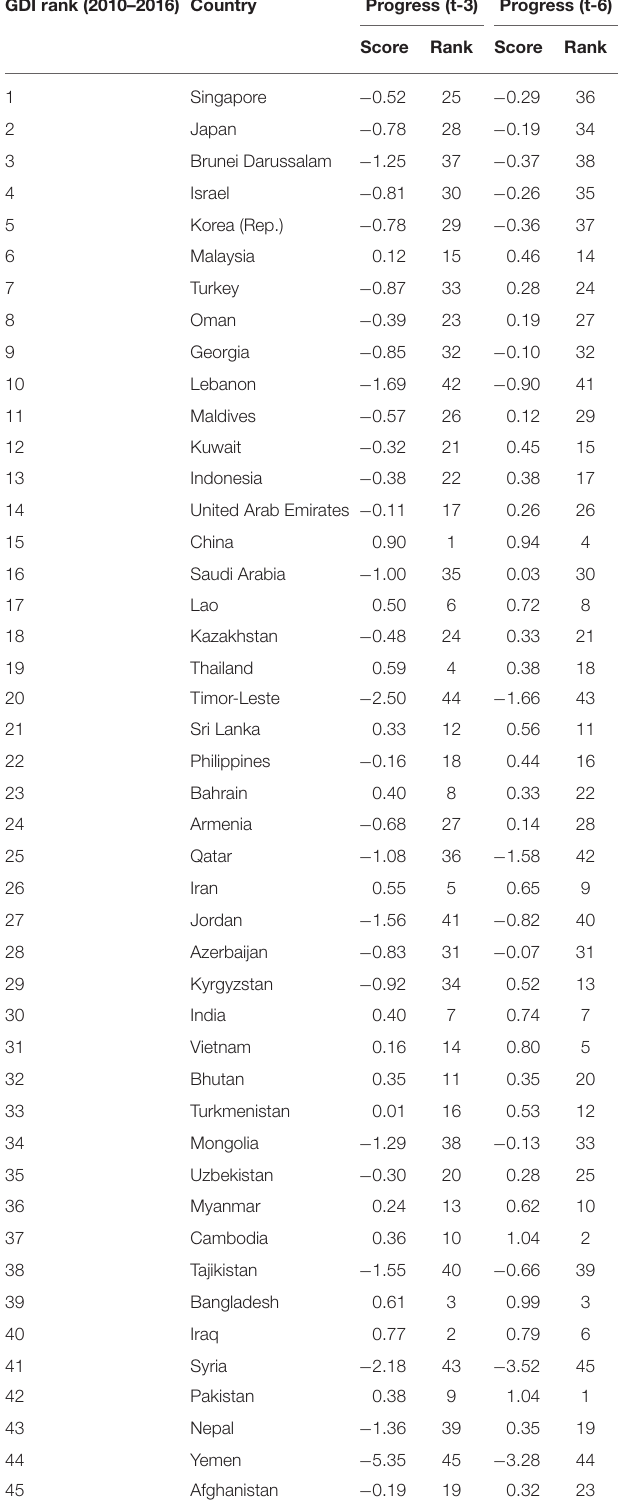
TABLE 4 | The progress score in different time spans. GDI rank (2010–2016)